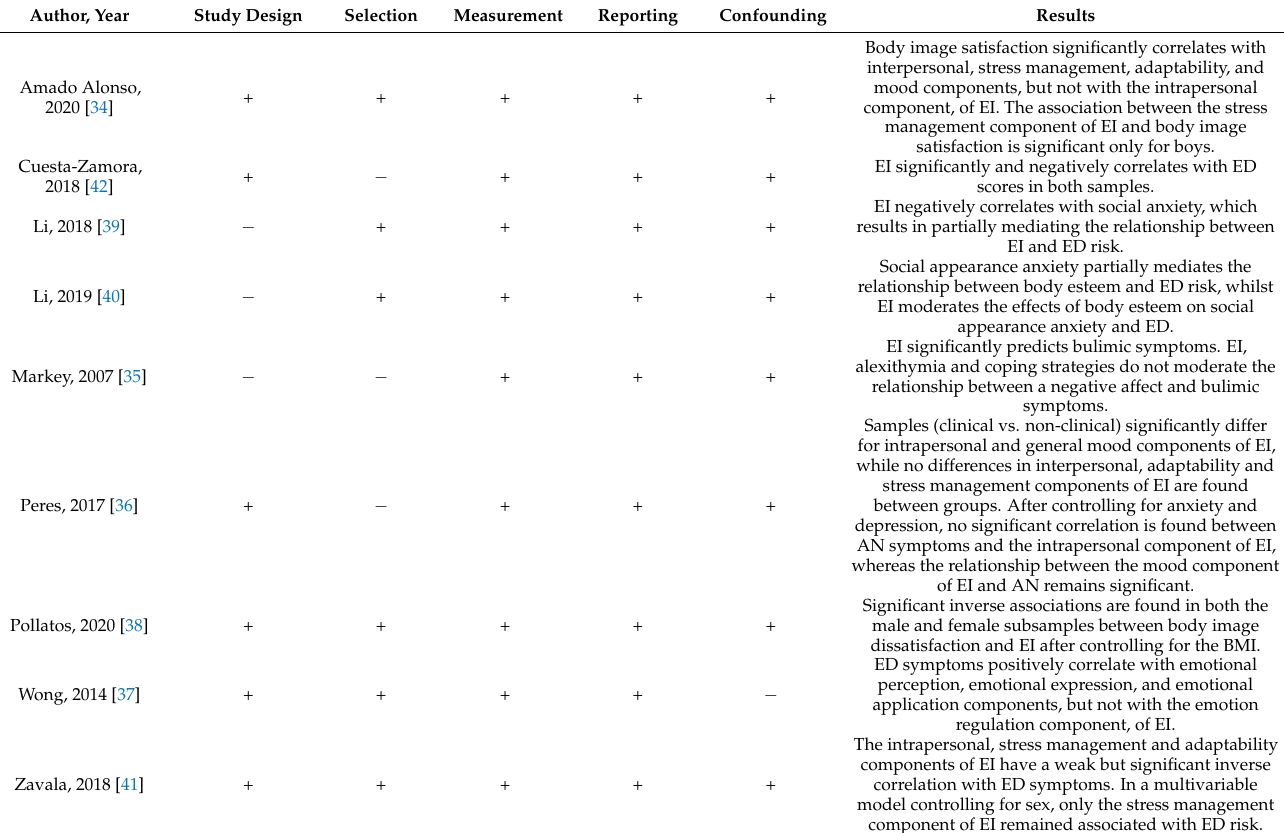
Table 2. Methodological quality and summary of results of the included studies ( n =